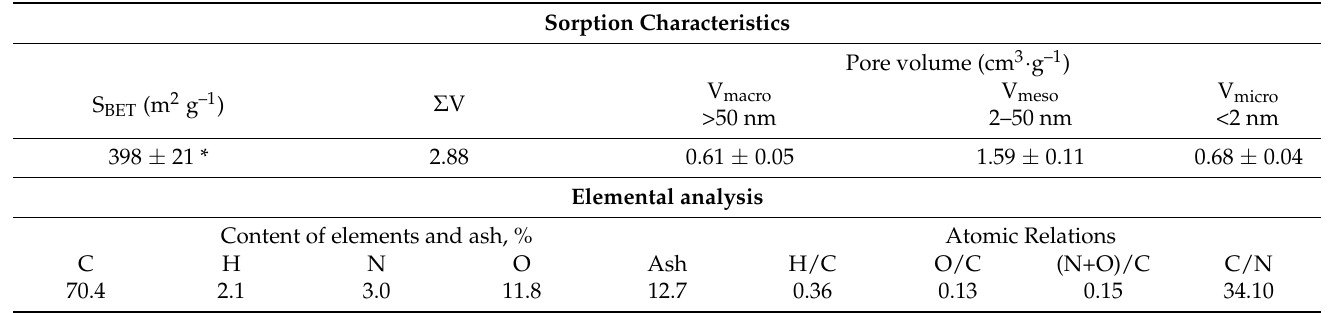
Table 2. Sorption characteristics and elemental composition of biochar obtained under optimal pyrolysis